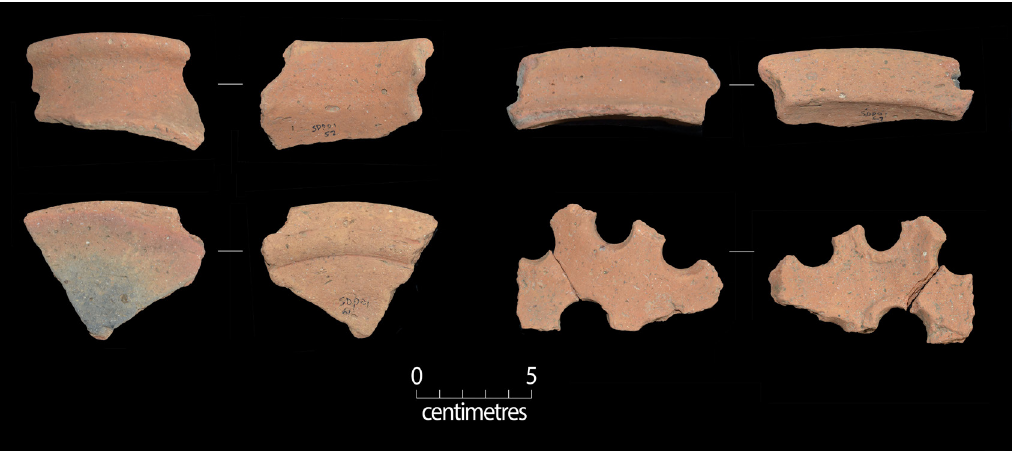
Figure 31: External and internal surfaces of four Class 10 variant 1 potsherds, including one perforated body sherd.